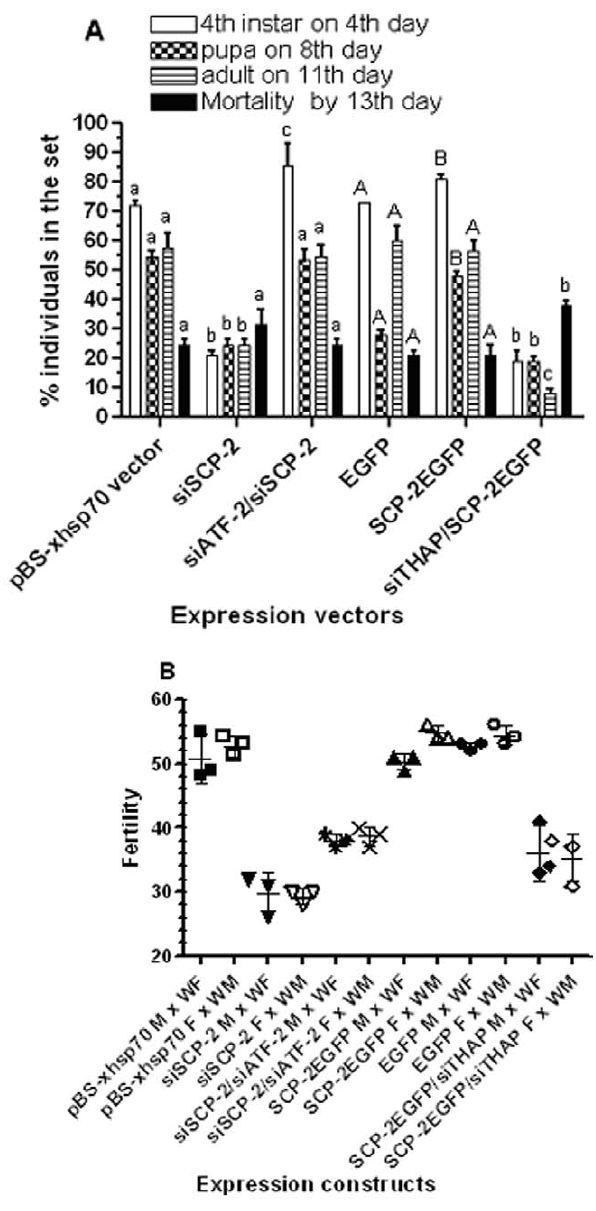
Figure 6. Effects of THAP and ATF-2 expression knockdown on development and fertility. The siRNA vector is driven by the Drosophila hsp70 short promoter (see M&M). Constitutive over expression is drive by the immediate early gene promoter (Vyazunova and Lan, 2010). In the co-transfected groups, two expression vectors were added at 1:1 ratio. In the single expression vector groups, pBS plasmid was added in at 1:1 ratio to normalized the total amount of expression vector each group received. Thirty larvae were synchronized on Day 1 2 nd instar; siRNA expression was induced via heat shocked at 37 u C for 24 hours on Day 1 of 2 nd and 4 th instar, respectively. Heat shock-treatment was not applied to the EGFP and SCP-2EGFP groups. ( A ) Developmental progression and mortality. The same letters above the bars in each construct represent that the mean values did not differ from other constructs significantly (p . 0.05) in paired t-tests within each observation. Lower case letter represents heat shock treated group, capital letter represents non-heat shocked group. ( B ) Female Fertility (after the 1 st bloodmeal). Fertility is defined as viable 2 nd instar larvae/ female. Survived pupae in each group from (Fig. 6A) were separated by sex and adults emerged in separated cages. Adults from each group (8– 12) were mated with 10 wild type opposite sex (WF=wild type female